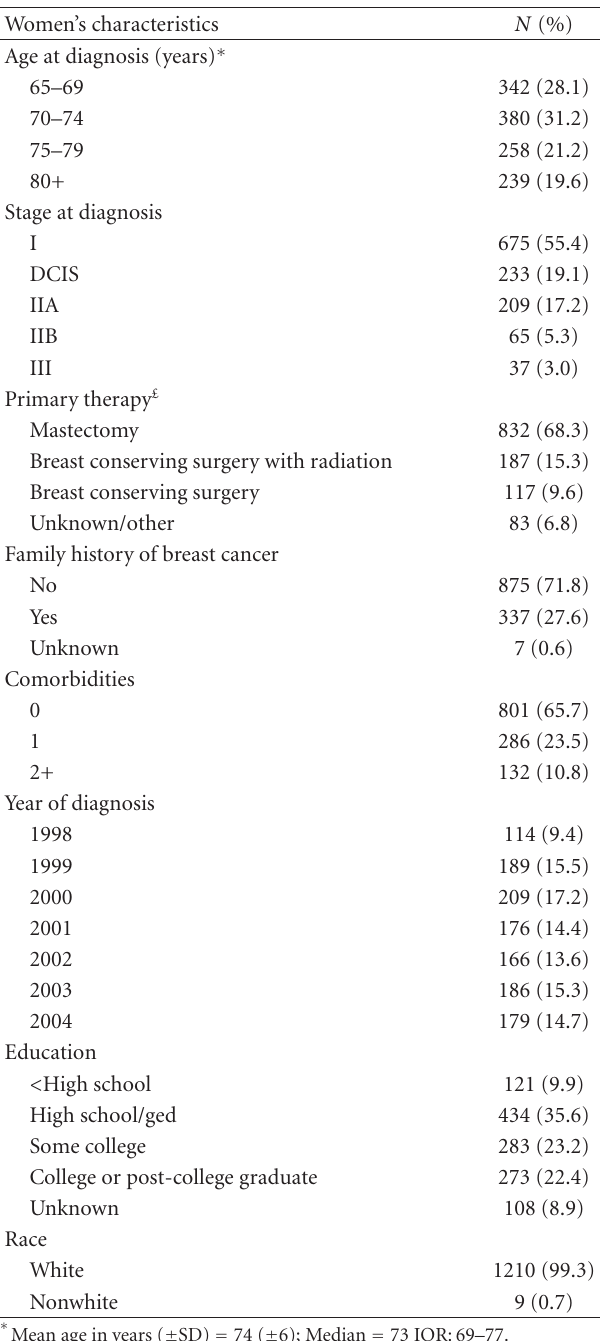
Table 1: Characteristics of 1219 women with a personal history of breast cancer in the New Hampshire Mammography Network (NHMN) and enrolled in Medicare